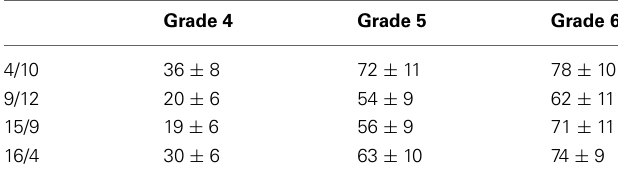
Table 6 | Mean percentage of correct responses and standard deviation for the simplification task in each